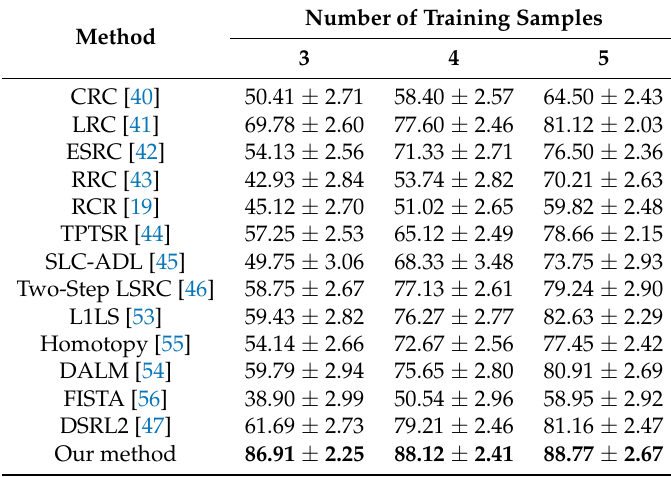
Table 2. Face recognition rates (%) of different methods on FERET database.